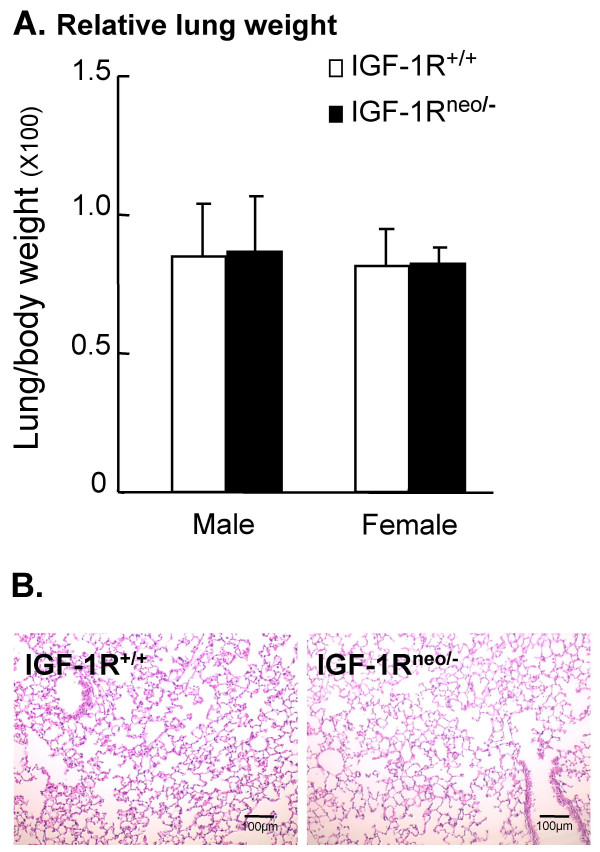
Lung weight and histology under basal conditions. (A) Mean values (×100) of lung-to-body weight ratio (± SD) in IGF-1R+/+ mice (male: n = 11; female: n = 5) and IGF-1Rneo/- mice (male: n = 7; female: n = 4). (B) Representative histology of hematoxylin-eosin stained lung sections from IGF-1R+/+ and IGF-1Rneo/- mice. Magnification: 10× objective.